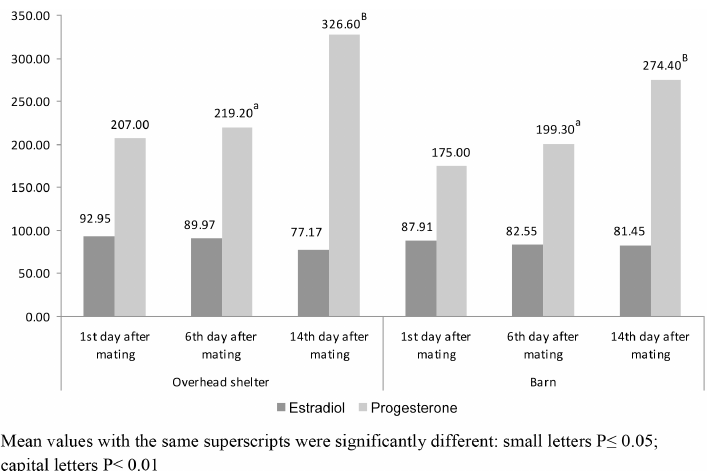
Figure 5. The concentration of progesterone and estradiol (pgmL − 1 ) in peripheral blood of ewes kept in the overhead shelter and in the barn at first day after mating as well as sixth and fourteenth days after mating.